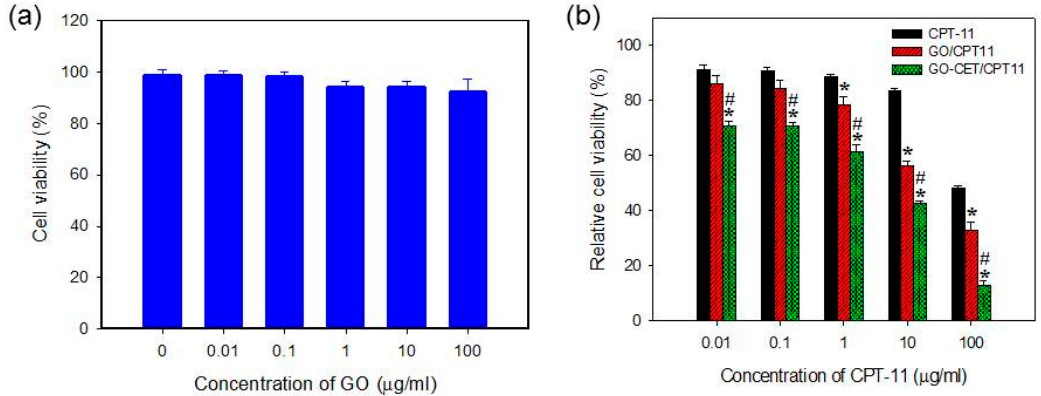
Figure 7. The biocompatibility of GO tested with 3T3 fibroblasts ( a ) and cytotoxicity of CPT-11 toward U87 cancer cells in different formulations ( b ). * p < 0.05 compared with CPT-11, # p < 0.05 compared with GO/CPT11.